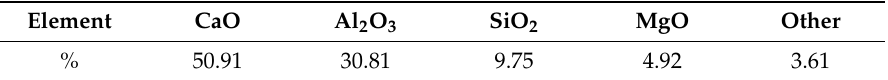
Table 2. The main chemical composition of slag in the trial, wt %.